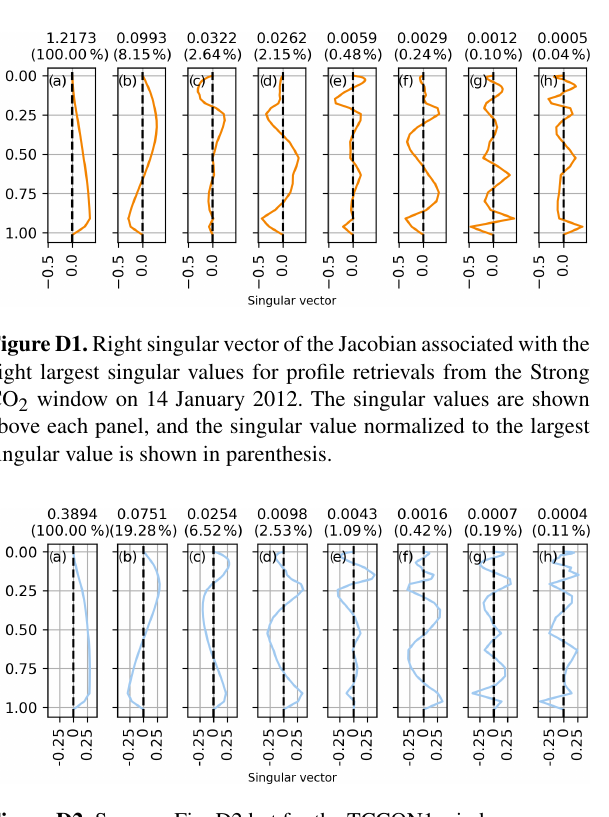
Figure D2. Same as Fig. D2 but for the TCCON1